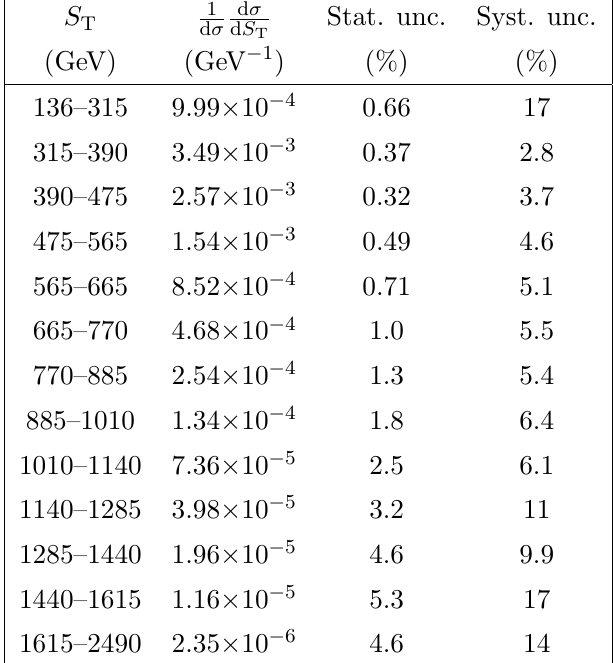
Table 6 . Results of the normalised di(cid:11)erential cross sections with relative uncertainties in the combined channel with respect to S T